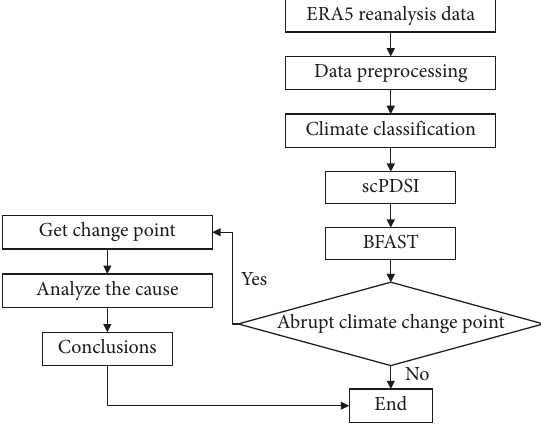
Figure 2: Graphical framework of methodology. Table 1: Drought category based on the scPDSI